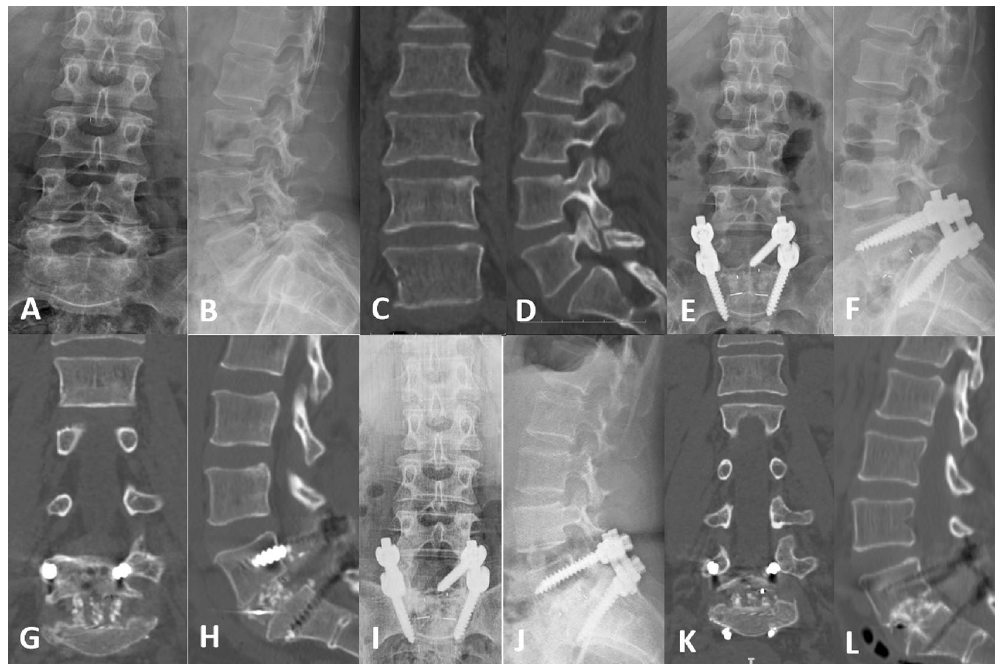
Figure 3. Radiological images of a representative case with CPS. ( A – L ) A 61-year-old osteoporotic female with isthmic spondylolisthesis in the L5/S1 segments. ( A – D ) Preoperative X-rays and CT showed forward slip of the L5 vertebra and L5 spondylolysis. ( E – H ) Postoperative X-rays and CT showed that the internal fixation position was good and that the L5 vertebra was well reset. ( I – L ) Postoperative X-ray and CT at 24 months after fusion surgery showed that the internal fixation device did not loosen or break, the vertebra did not show slippage, and the intervertebral fusion was